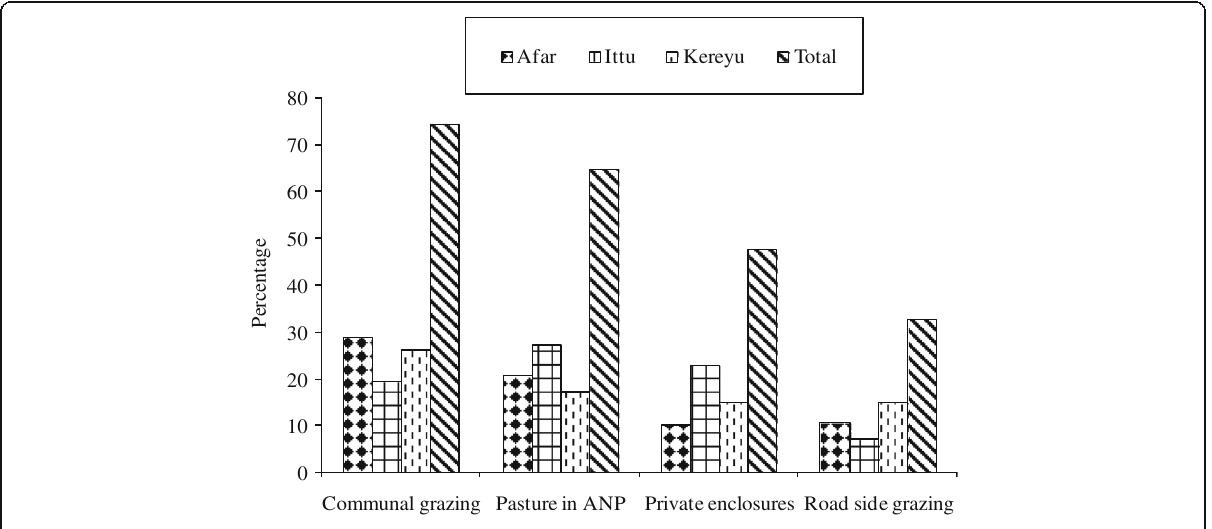
Fig. 2 Utilization of livestock grazing areas by ethnic groups around Awash National Park, Ethiopia